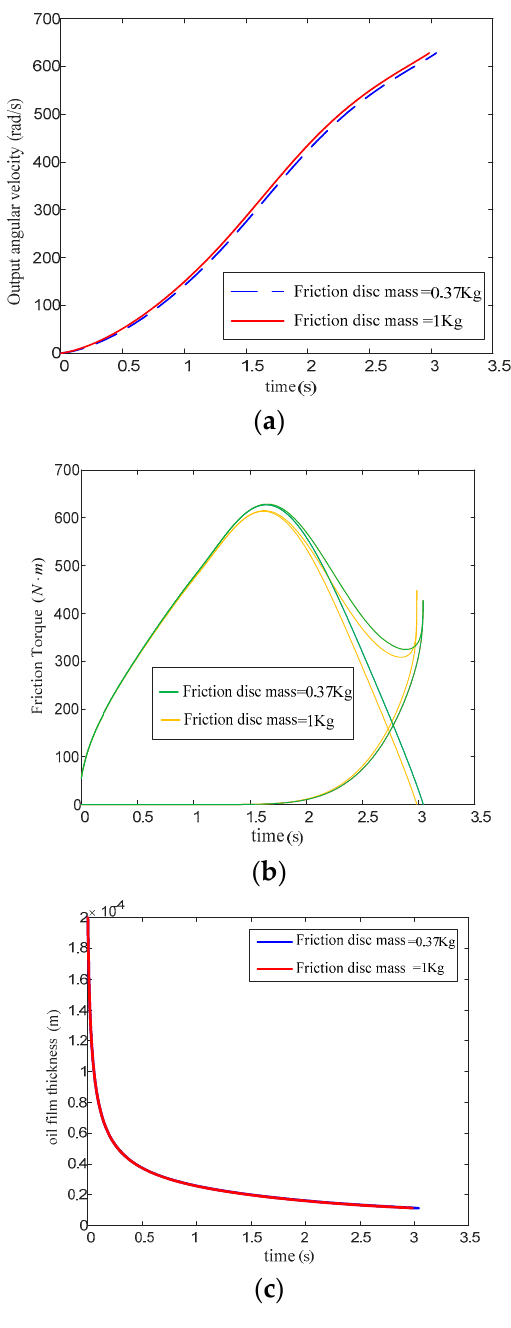
Figure 14. E ff ect of friction plate mass on output speed, friction torque, and film thickness. ( a ) E ff ect of friction plate mass on output speed; ( b ) E ff ect of friction plate mass on friction torque; ( c ) E ff ect of friction plate mass on oil film thickness.